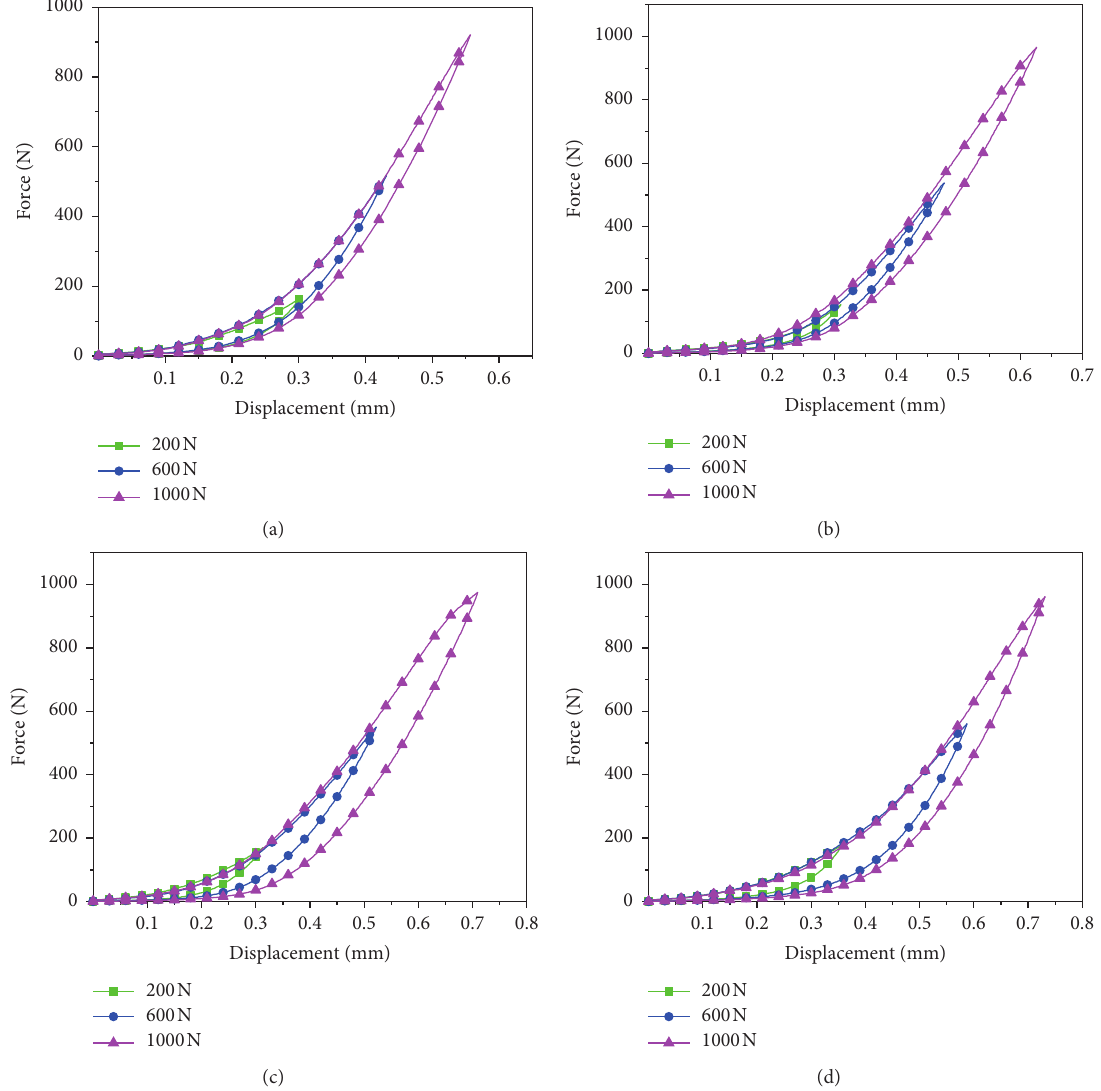
Figure 8: Displacement variation diagram of sample under different loads. (a) Porosity � 51.5%. (b) Porosity � 57.6%. (c) Porosity � 63.7%. (d) Porosity �